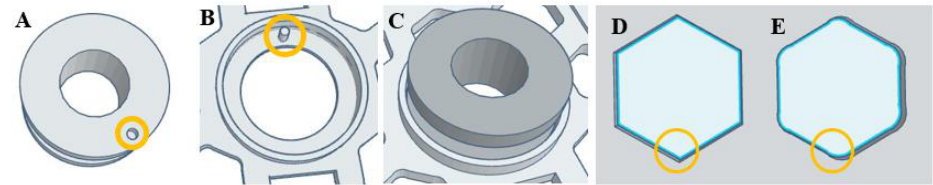
Figure A4. Characteristic of the design of the orthosis, ( A ) connection provided on the coil of the electrostimulation transducer; ( B ) connection for the transducer on the fixing mesh; ( C ) integration of the transducer with the mesh; ( D ) conventional hexagonal pattern of holes for printed orthoses and ( E ) model proposed for this orthosis with rounded corners.